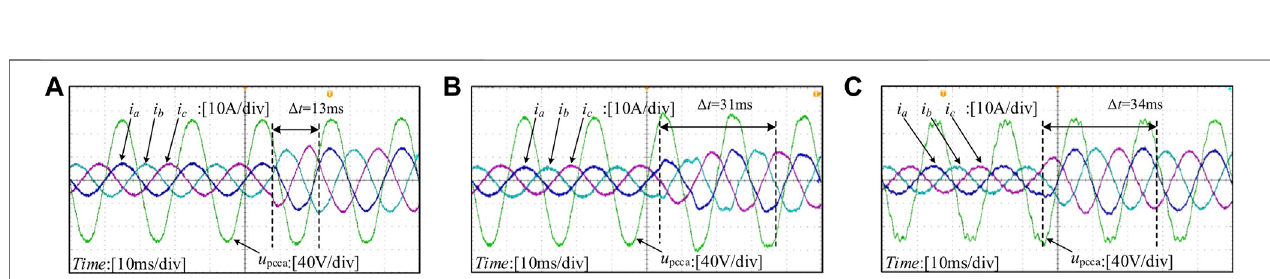
FIGURE13| Dynamicexperimentalresultsoftheinverterat L g (cid:1) 3 mH: (A) withtheproposedmethodinthispaper, (B) withthemethodinRef.Liuetal.(2020),and (C) with the method in Jiao and Lee (2015).